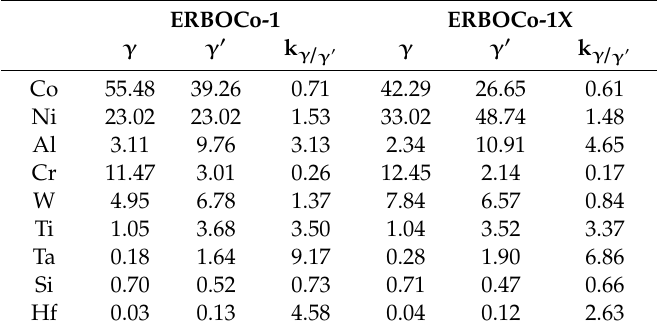
Figure 5. ( a , b ) Proximity histograms across the large γ / γ′ interfaces shown in Figure 4a,b. Table 3. Phase compositions in at.% and partitioning coe ffi cients of solutes in ERBOCo-1 and ERBOCo-1X after